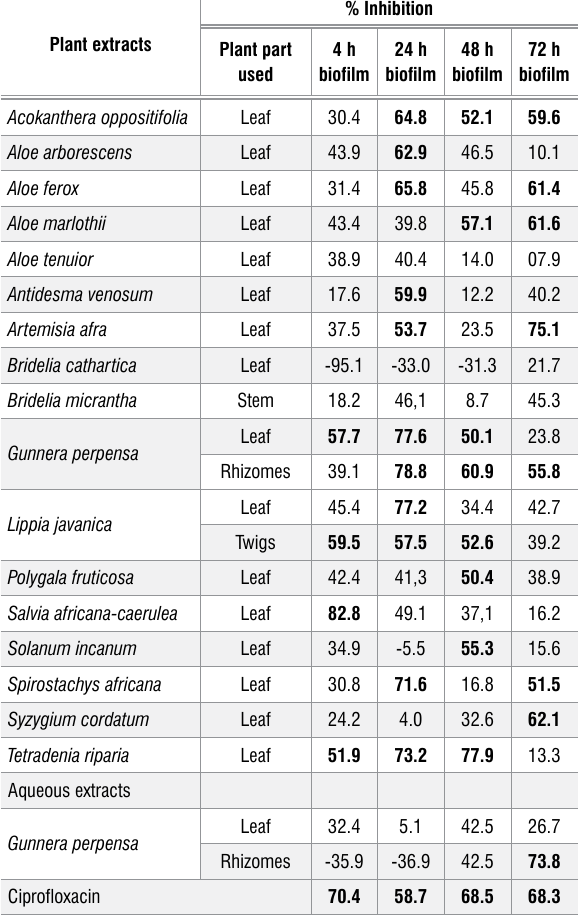
The antibiofilm activity of plant extracts against C.